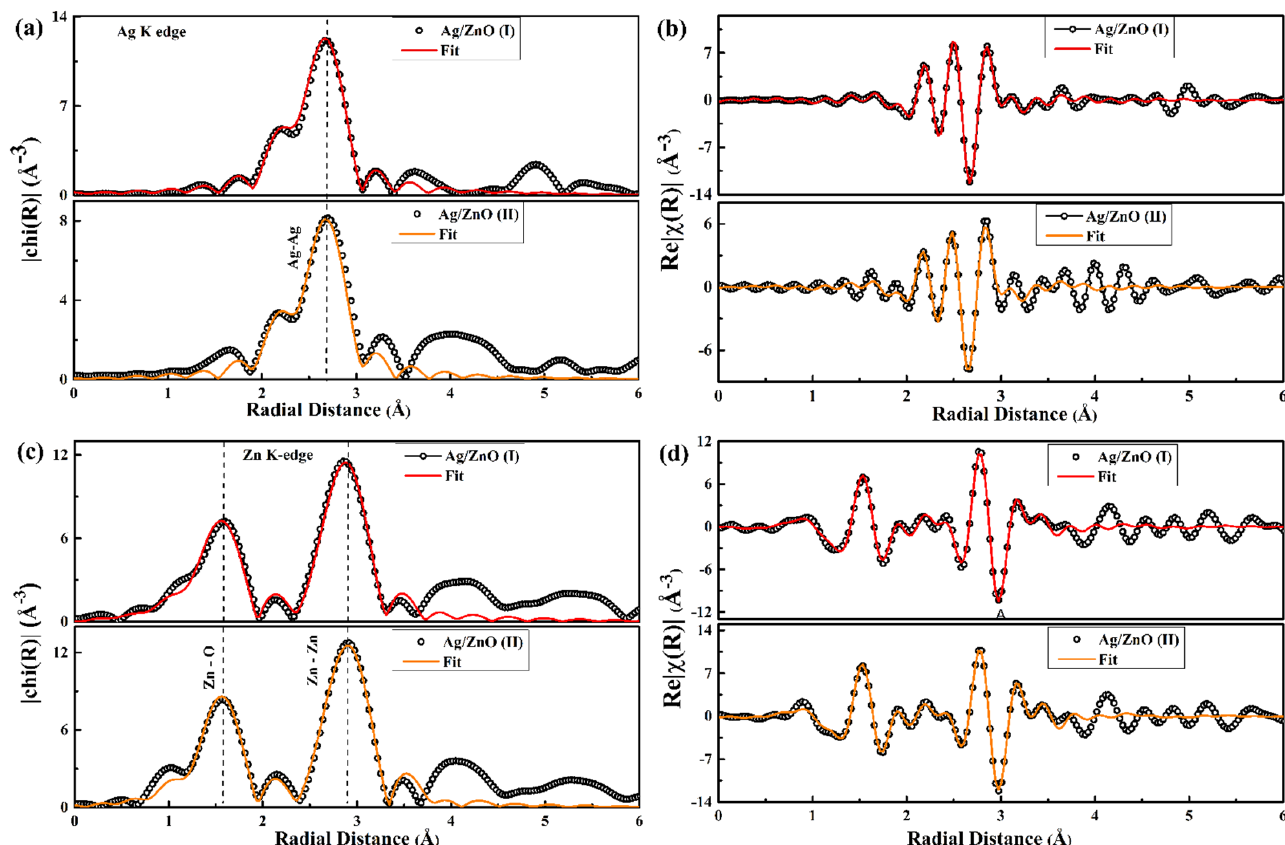
Figure 8. ( a,c ) Magnitude and ( b,d ) real component of χ (R) for Ag/ZnO (I) and Ag/ZnO (II) samples. Figure 8. ( a , c ) Magnitude and ( b , d ) real component of χ (R) for Ag/ZnO (I) and Ag/ZnO (II) samples. The real part of 𝜒(𝑅) R spectra for the Zn K edge in Figure 8c indicates two major Using the fcc Ag cif file, the EXAFS fitting of experimental Ag K edges for Ag/ZnO peaks corresponding to the nearest Zn–O coordination and second nearest Zn–Zn coordination. The modelling for the Zn K edge was performed with the hexagonal wurtzite ZnO cif file. The R values for Zn–O and Zn–Zn do not indicate any significant changes in Ag/ZnO (I) or Ag/ZnO (II) samples with different synthesis routes. The CN values for Zn–O coordination were 2.9 (4) and 2.9 (3) for Ag/ZnO (I) and Ag/ZnO (II)